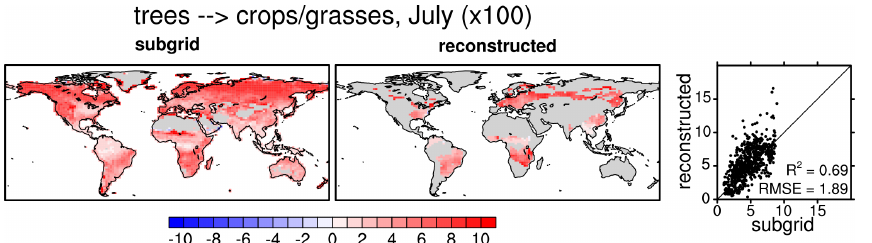
Figure 4. Sub-grid (left) and reconstructed (middle) estimates of the present-day (2002–2010) potential albedo change associated with a transition from trees to crops–grasses in the CLM4.5 simulations for the month of July. The scatter plots (right) indicate the relationship between reconstructed ( y axis) and sub-grid estimates ( x axis), with each dot indicating the results of a grid cell for which both methods could be applied. Note that absolute differences have been multiplied by 100 to facilitate reading.